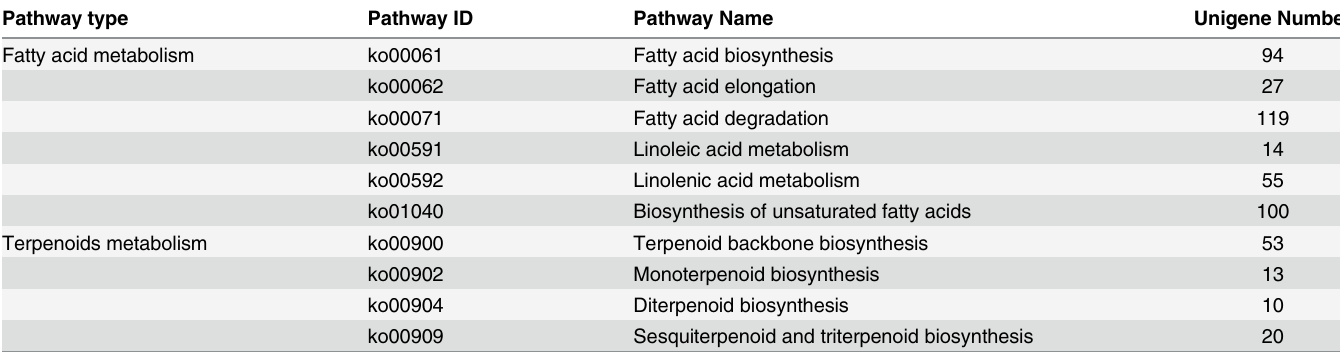
Table 3. Summary of unigenes related to lipid and terpenoid